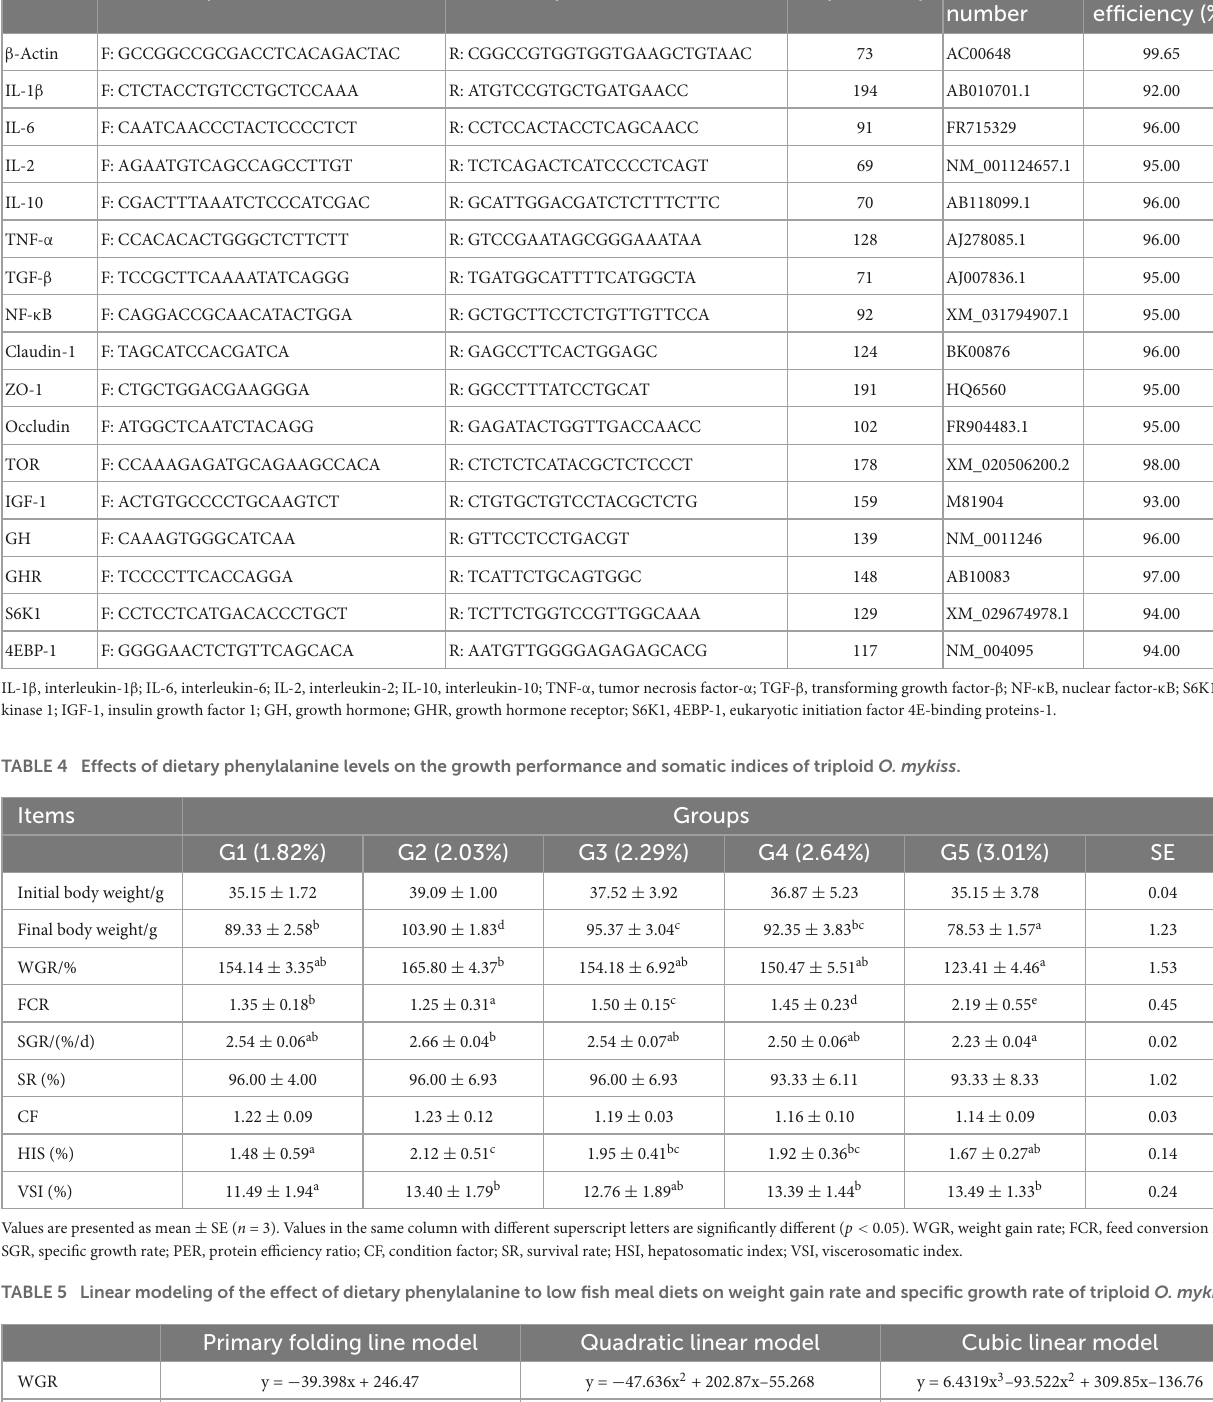
TABLE 3 Primer sequences used for gene expression analyses.